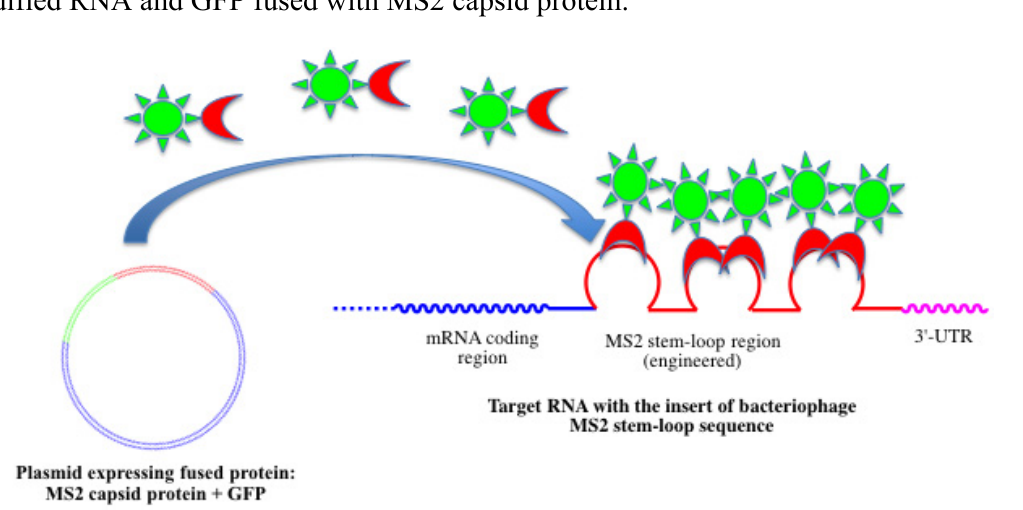
Figure 11. Bacteriophage MS2 genetic encoding system for RNA detection using genetically modified RNA and GFP fused with MS2 capsid